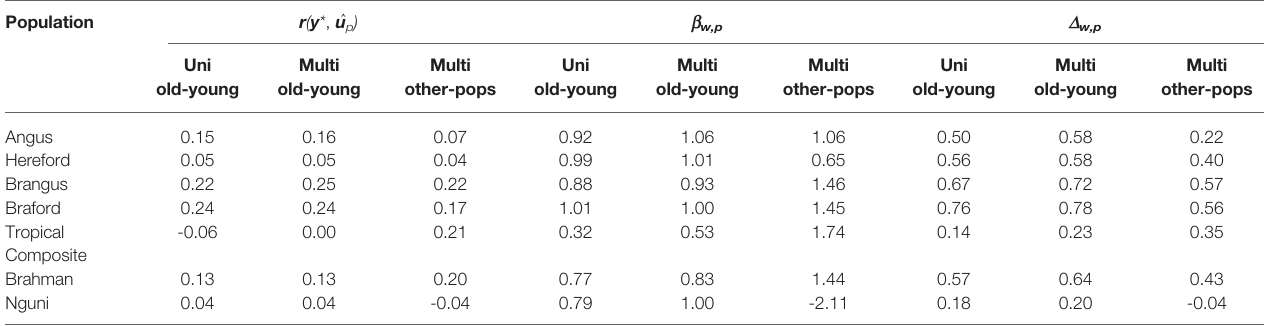
TABLE 4 | Predictive ability 1 [r( y* , u ̂ p )], regression coef fi cient ( b w,p ) and correlation between genomic breeding values ( u ̂ ) predicted from whole ( w ) and partial 2 ( p ) data using uni and multivariate ssGBLUP population analyses.